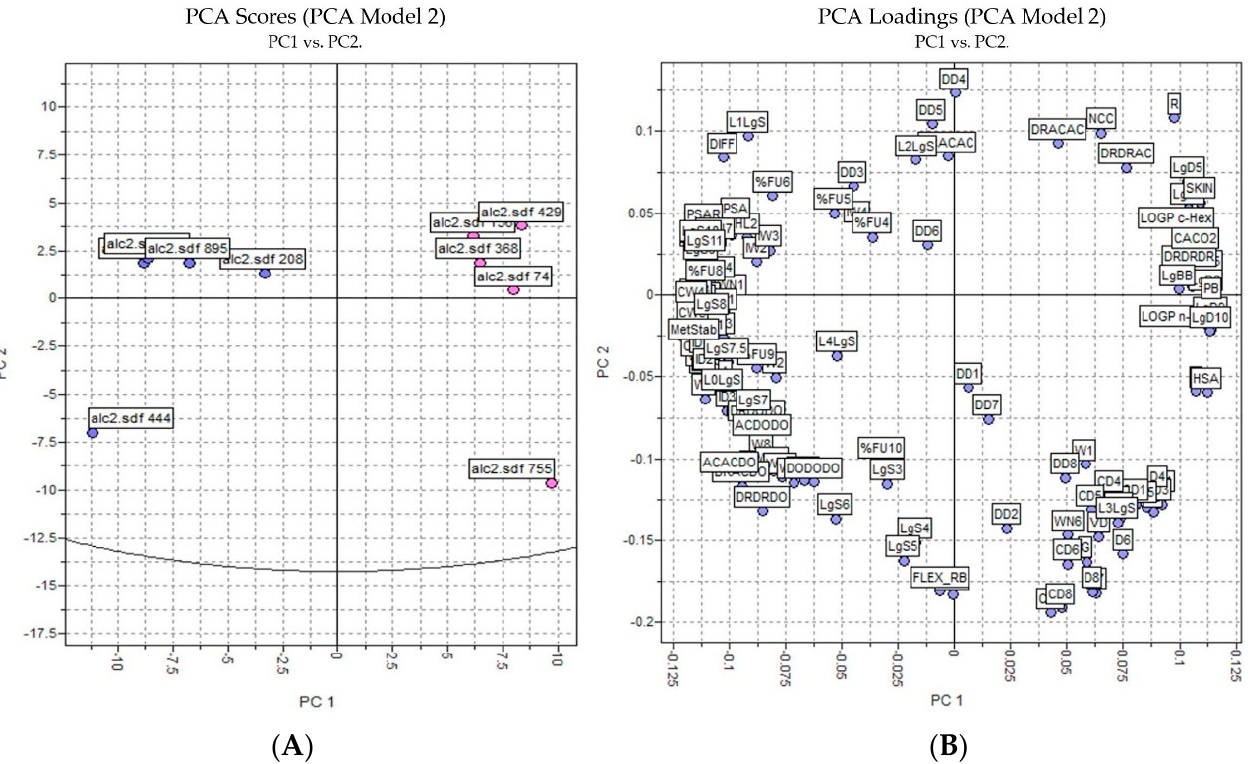
Figure 3. PCA analysis applied to the more active and less inactive alkaloids: ( A ) score plot (blue— active alkaloids, red—inactive alkaloids) and ( B ) loading plot.